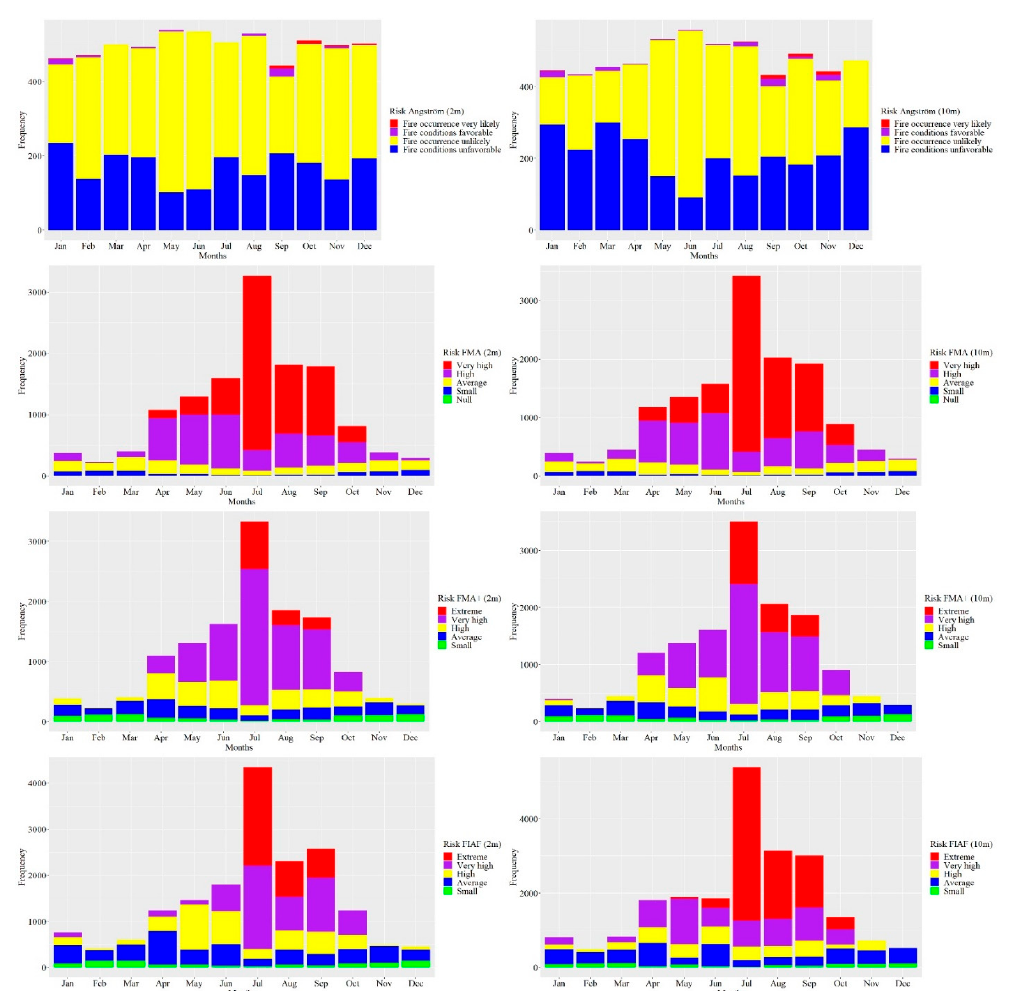
Figure 6. Correlation matrix between observed fire foci (FF) data and the FIAF model for the two levels of 2 and 10 m (FIAF_2m and FIAF_10m) during the years 2018 to 2021 in Itatiaia National Park, Brazil.